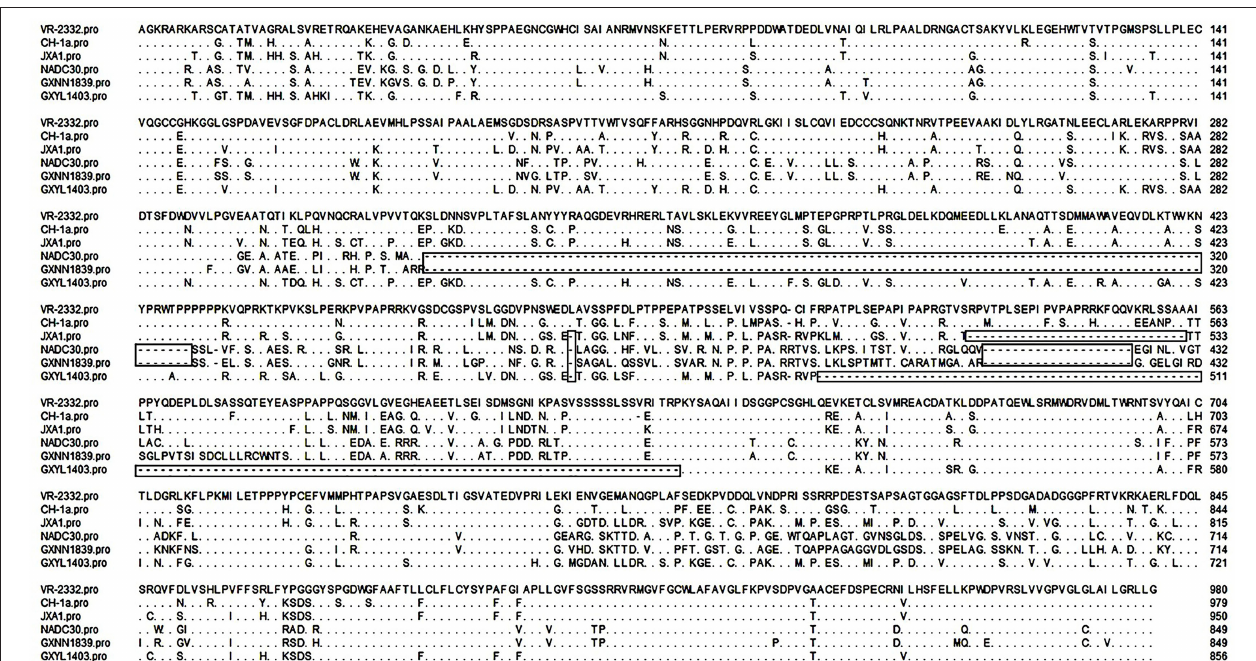
FIGURE 1 | Identification of PRRSV strains with amino acid deletion in nsp2. Multiple alignments of nsp2 were performed by Clustal W. The sequence of VR-2332 is shown on the top; the residues conserved with it are hidden. The deleted amino acids are labeled with